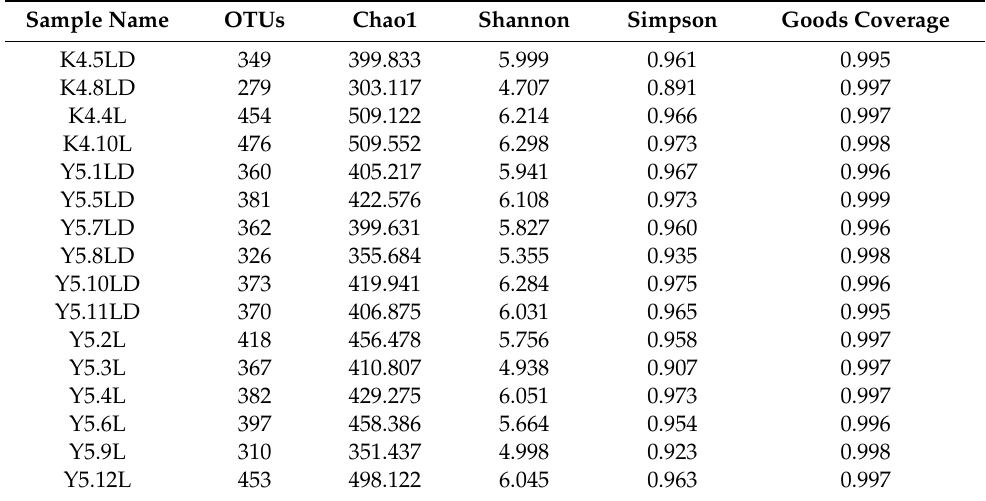
Table 3. Summary of community richness and diversity of all samples from both growth stages.